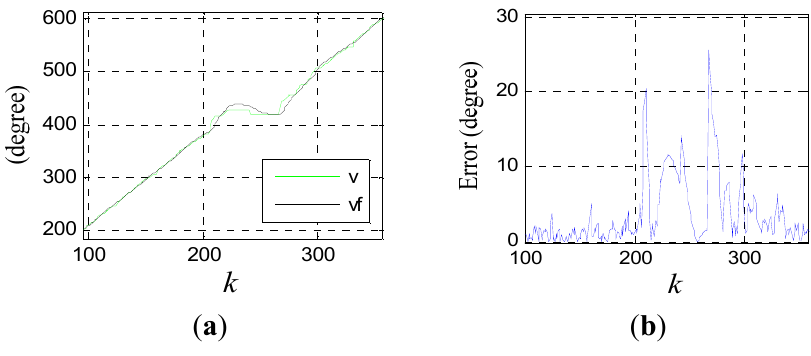
Figure 22. ( a ) Forecasted effect ( b ) error signal.